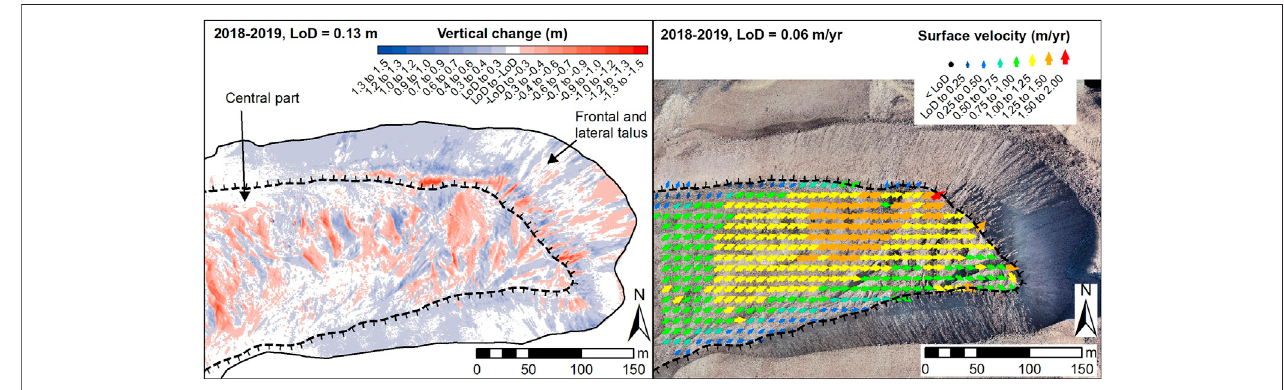
FIGURE8| UAV-derived verticalchangesandsurfacekinematicsofTapado1rockglacier(T1rg)betweenJanuary2018andMarch 2019.Thebackgroundimage corresponds to the UAV-derived orthomosaic from March 2019.